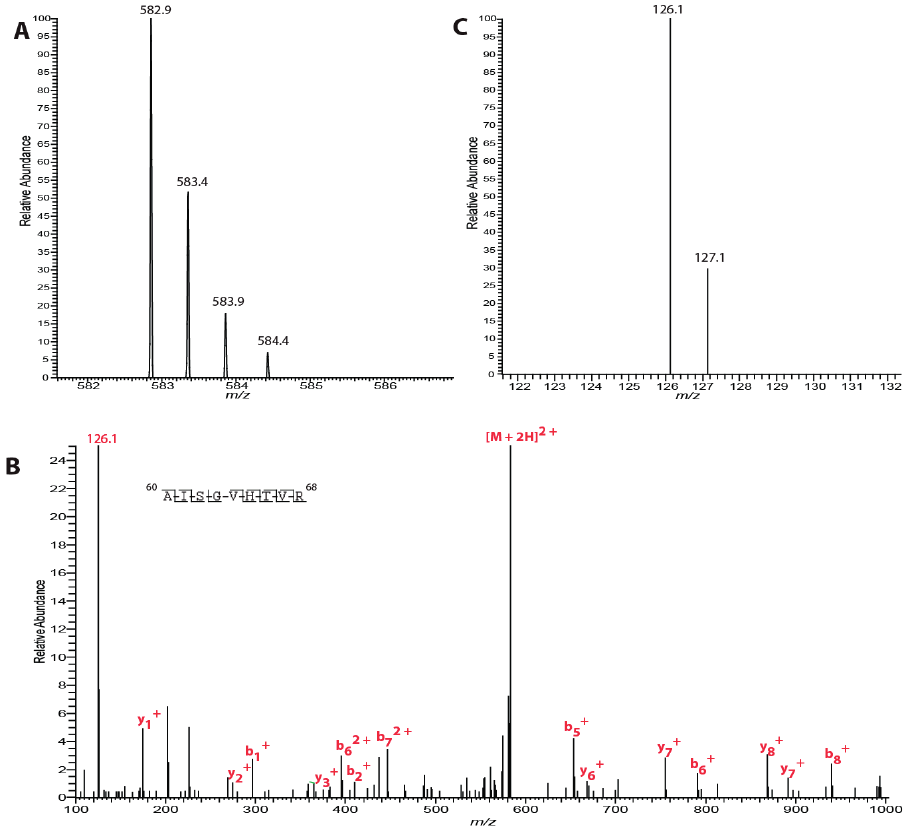
Figure 1. Quantification of phosphorylation on Thr-66 on eIF2 γ . ( A ) Precursor ion mass scan of the [M + 2H] 2+ ion is shown; ( B ) MS/MS spectra of m / z ion 582.9 illustrating indicative b- and y-ions for peptide spanning residues 60–68 of eIF2 γ ; and ( C ) Zoomed in view of the m / z region containing the TMT (tandem mass tags) reporter ions. Calculation of the reporter ion ratio reveals a phosphorylation level of 70.5% for